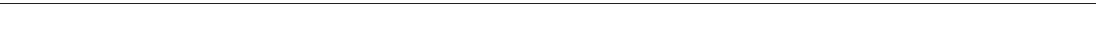
Fig. 2 High con fl uent cells show dramatic reduction of stress fi bers formation and have low expression of actomyosin proteins via YAP/TAZ inhibition. a mRNA levels of the indicated proteins relative to GAPDH (control) in MCF10A cells plated at different con fl uencies: LC and HC. b mRNA levels of the indicated proteins relative to GAPDH (control) in MCF10A cells treated with YAP/TAZ siRNAs. c Densitometry of the indicated protein levels relative to GAPDH (control) in MCF10A cells plated at different con fl uencies: LC and HC. d Densitometry of the indicated protein levels relative to GAPDH (control) in MCF10A cells treated with YAP/TAZ siRNAs. e Relative promoter enrichment in YAP of the indicated genes. MCF10A cells were seeded at LC and HC and subjected to ChIP:YAP analysis. Bars represent the mean ± s.d. of one representative experiment performed in triplicates (*** P < 0.001, ** P < 0.01, * P < 0.05; two-tailed t -test). The experiment was repeated at least another 2 times with similar results. f Representative images of F-actin (Phalloidin) immunostaining in MCF10A cells plated at low and high con fl uencies and exposed to either Ctrl or YAP/TAZ double knockdown. Scale bar is 10 µ m. g Representative images of F-actin (Phalloidin) immunostaining in MCF10A cells plated at high con fl uency and treated with LATS1/2 siRNAs. The number of cells with stress fi bers is rescued by LATS1/2 KD (see right panel). h Representative western-blots for the indicated proteins in MCF10A cells plated at high con fl uency and treated with LATS1/2 siRNAs. The levels of the indicated proteins are rescued by LATS1/2 KD. i Relative mRNA levels of the indicated genes to GAPDH in MCF10A cells exposed to LATS1/2 and/or YAP/TAZ siRNAs. The treated cells were seeded at low and high con fl uencies. Bars represent the mean ± s.d. of one representative experiment performed in triplicates (*** P < 0.001; two-tailed t -test). j MCL2 levels assessed by immunoblotting in HeLa cells plated at different con fl uencies and overexpressing control (Ctrl), YAP(5SA) or YAP(5SA/S94A). GAPDH was used as loading control. MLC2/GAPDH densitometry is displayed on the right panel. The graphs show the mean ± s.e.m. ( n = 4; *** P < 0.001, ** P < 0.01, * P <